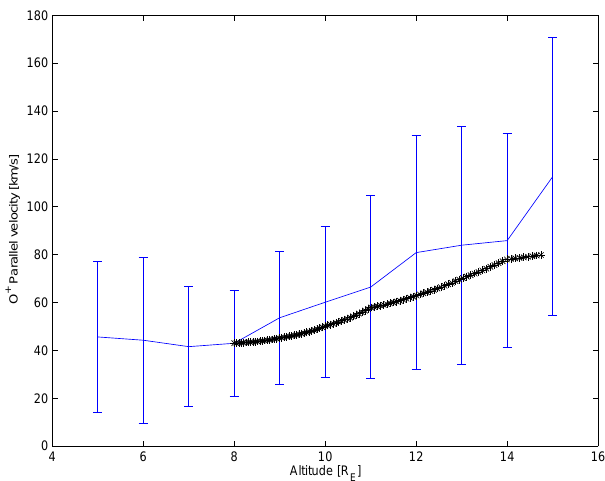
Fig. 6. Profile of the parallel velocity versus altitude. The blue error bars show the standard deviation for the linear values. The black dots are the calculated parallel velocities from the test particle calculation. (5–8 R E ), our measurements are probably far into the polar cap, while higher altitude measurements correspond to both the cusp and the polar cap poleward of the cusp (see Fig. 1). Our estimates of the spectral density and temperature at the lowest altitudes are likely too small to be representative of the cusp at 5–8 R E . A future study should also include the mid-altitude cusp.